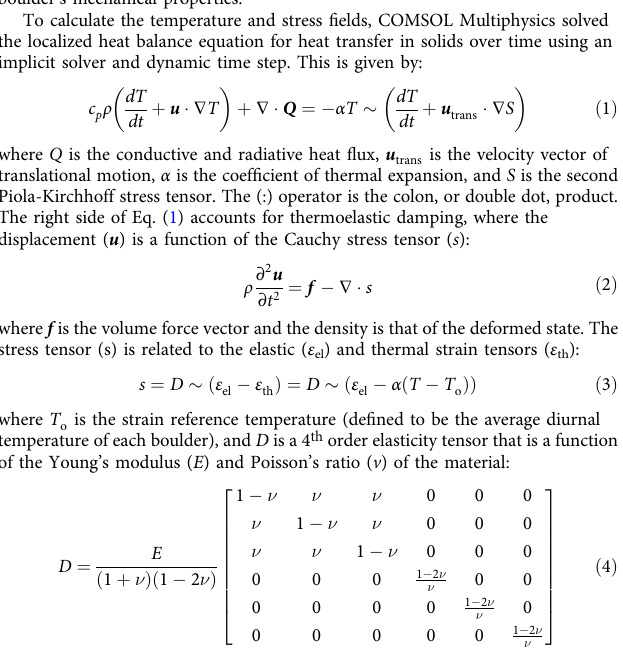
density of the regolith was the bulk value for Bennu 1190 kg/m 3 53 , and the thermal conductivity was adjusted such that the averaged thermal inertia of the model 0.076 W/m K and 0.125 W/m K for the regolith surrounding dense and porous boulders, respectively. While Bennu ’ s surface is known to be rougher and denser